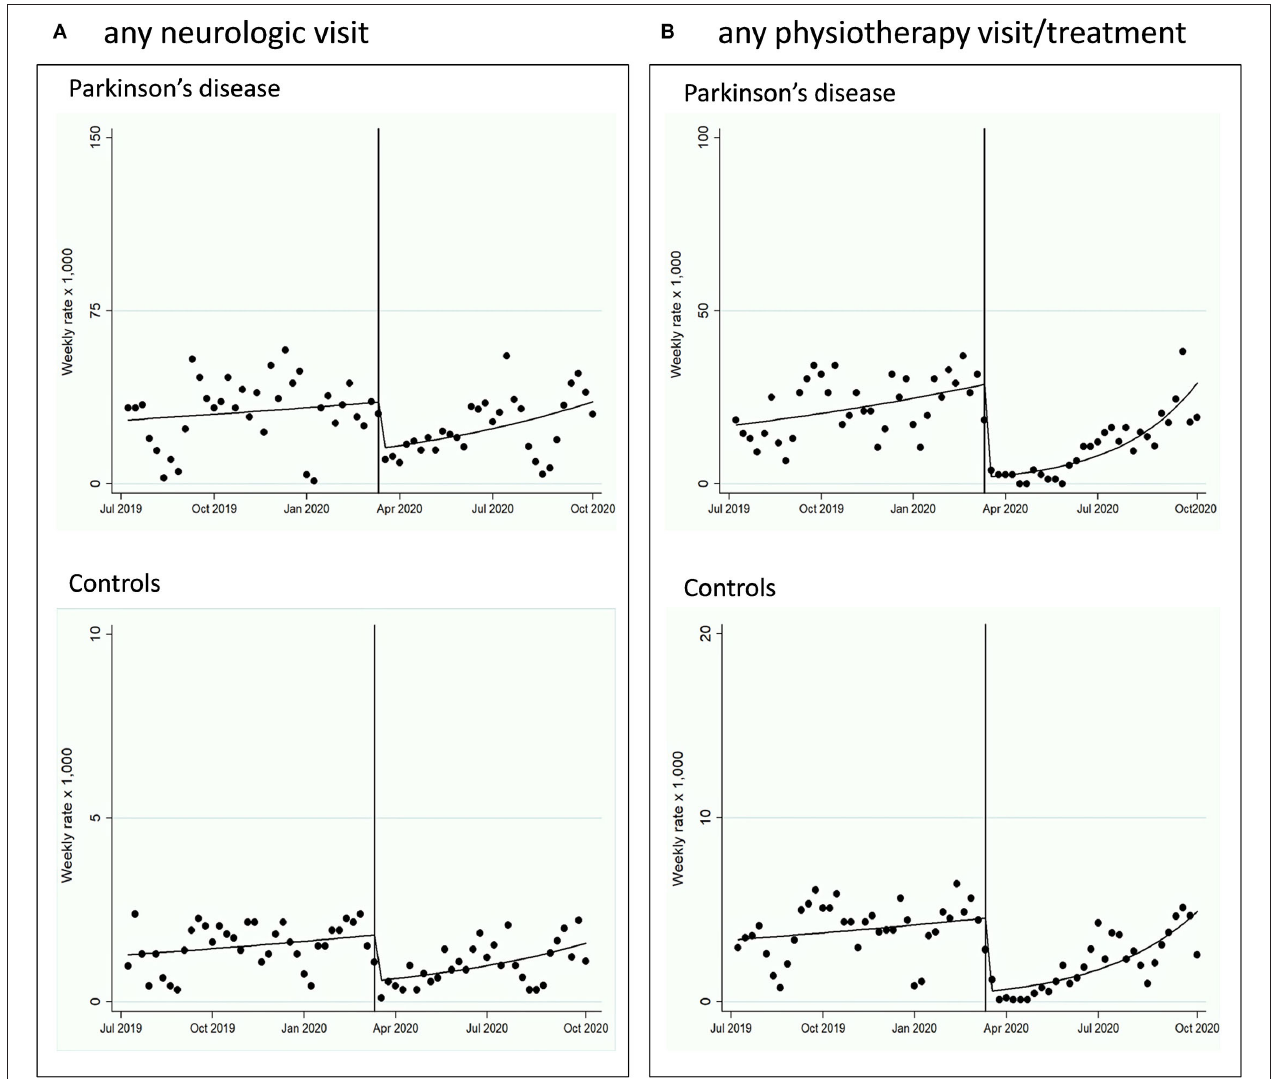
FIGURE 3 | Interrupted time-series (ITS) design, from July 1, 2019, to September 30, 2020, evaluating the healthcare services change in the PD and control cohorts. The pre-intervention period was from July 1, 2019, to March 8, 2020; the intervention (index week change) was set in the week of March 9–15, 2020;